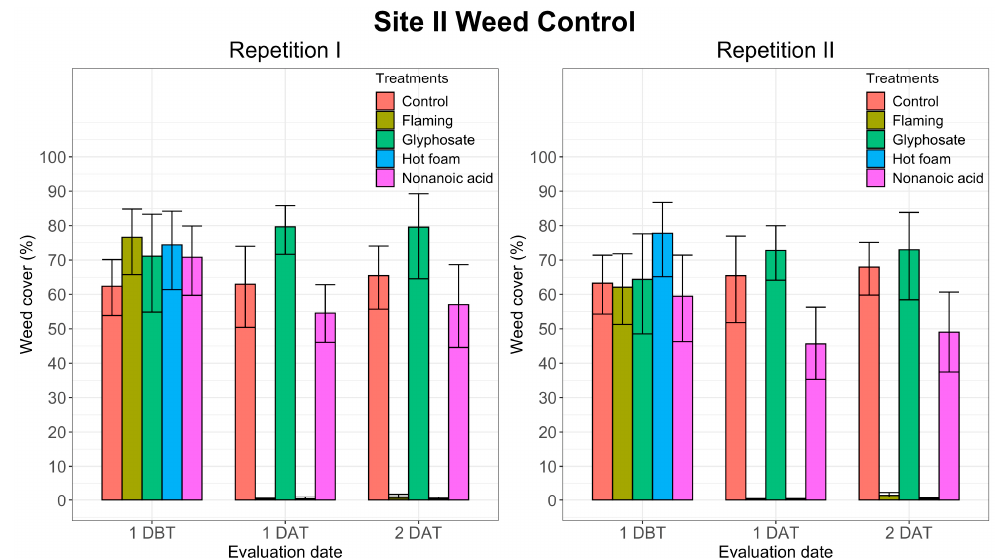
Figure 3. Weed control bar graph of back-transformed means (Table 3) and the 95% confidence interval as affected by the treatments (control, flaming, glyphosate, hot foam and nonanoic acid), repetition (I and II) and evaluation date at site II; 1 DBT, 1 DAT and 2 DAT: one day before, and one and two days after the treatment, respectively.